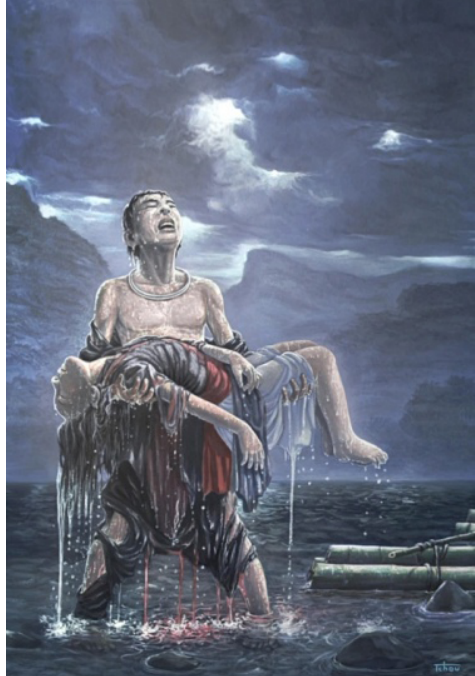
Figure 1. Drama Mekong Reproduced courtesy of Txeuying